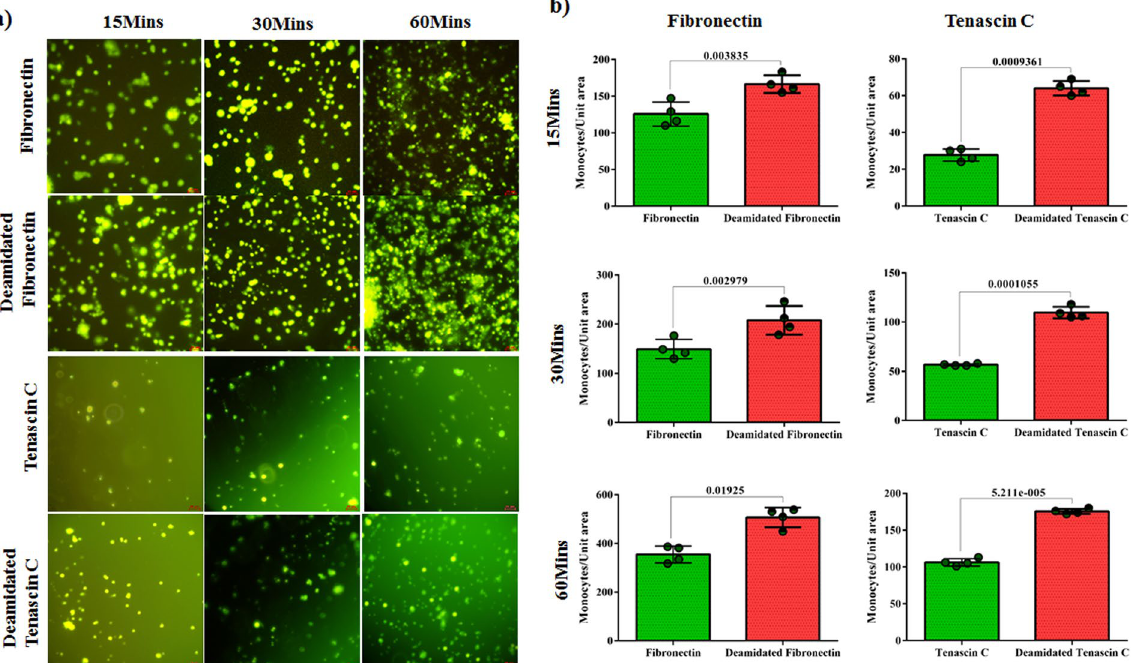
Figure 5. Microscopy images of primary human monocyte adhesion to culture plates coated with fibronectin or tenascin C native proteins (PBS-only treated controls) or the deamidated forms of these ECM components (50 mM TEAB treated). Isolated monocytes were labelled with CFSE dye and the images captured using green fluorescent filter. Scale bar indicates 20 µ m. Statistics were calculated from 4 experimental